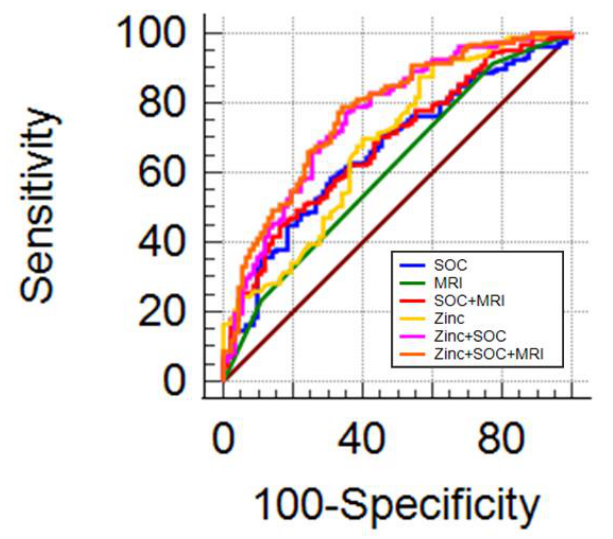
Figure 5. Diagnostic performance of zinc and MRI: AUC ROC for SOC (blue line), MRI (green line), SOC + MRI (red line), zinc (yellow line), zinc + SOC (pink line), zinc + SOC + MRI (orange line). Table 7. Diagnostic performance of zinc and MRI.